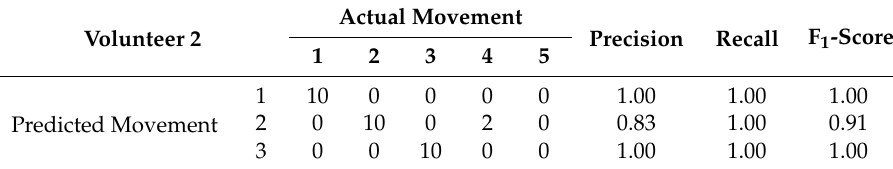
Table A2. Results Volunteer 2.